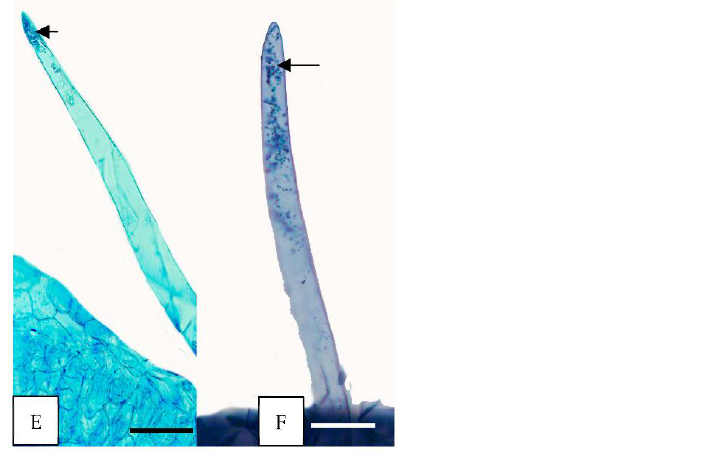
Figure 5. Histochemical tests of the floral glands of H. lacunosa . ( A – D ) Fragments of secondary nectaries tissue ( sn ). ( E , F ) Cylindrical trichomes ( cyt ). ( A ) Polysaccharides in nectariferous tissue stained pink (PAS); ( B ) few starch grains (arrows, IKI); ( C , E ) protein stained with CB; ( D , F ) numerous blue-black lipid droplets in the cells (arrows, SBB). PAS = periodic acid-Schiff reaction; IKI = Lugol’s reagent; CB = Coomassie Blue; SBB = Sudan Black B. Scale: ( A ) = 200 µm, ( D , F ) = 100 µm, ( B , C ) = 50 µm.